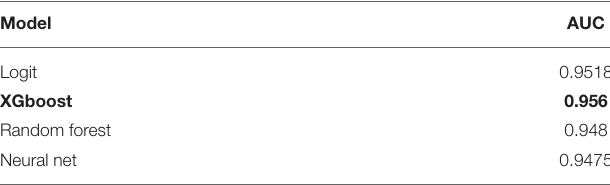
TABLE 2 | Comparison of models employed in the base case